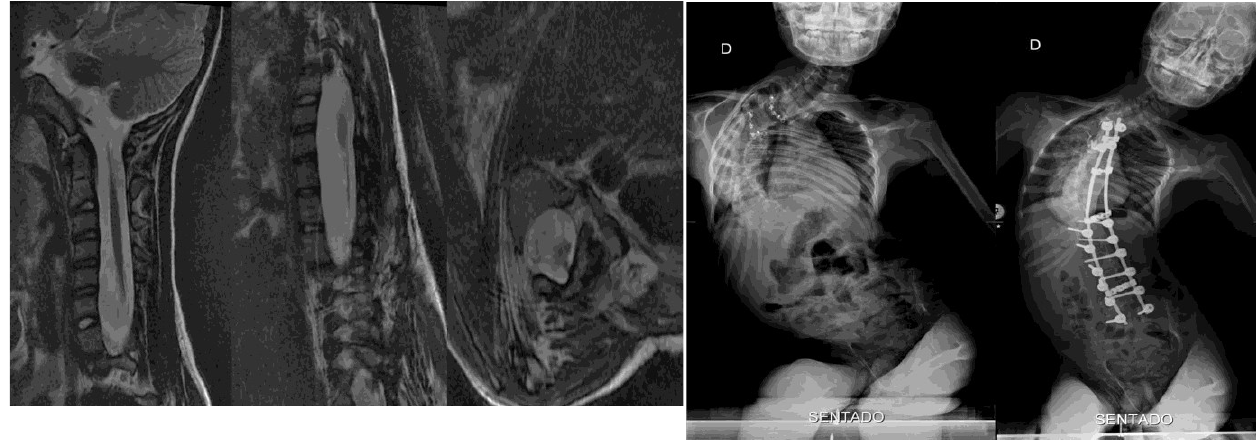
Figure 3 - Postoperative MRI in both sagital (A and B) and axial (C) views showing no residual dermoid cyst.